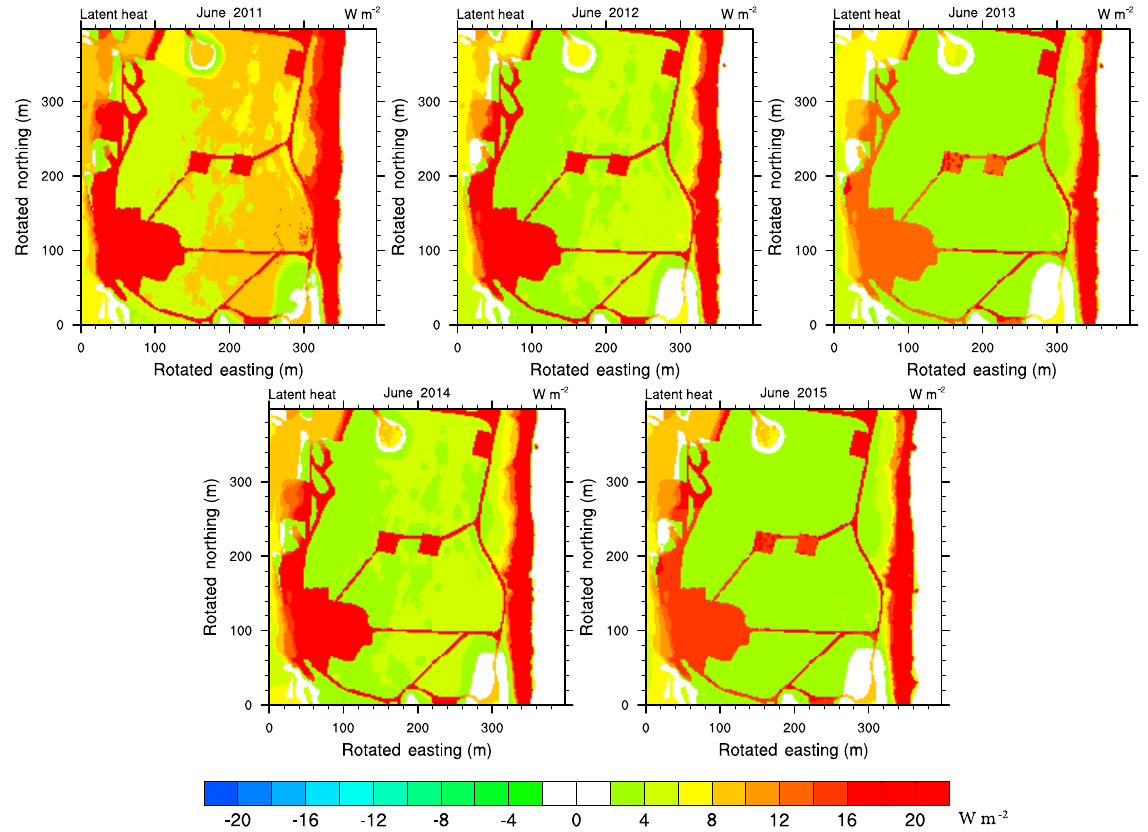
Figure 9. Difference between simulated latent heat fluxes by S E2m and S 2m in